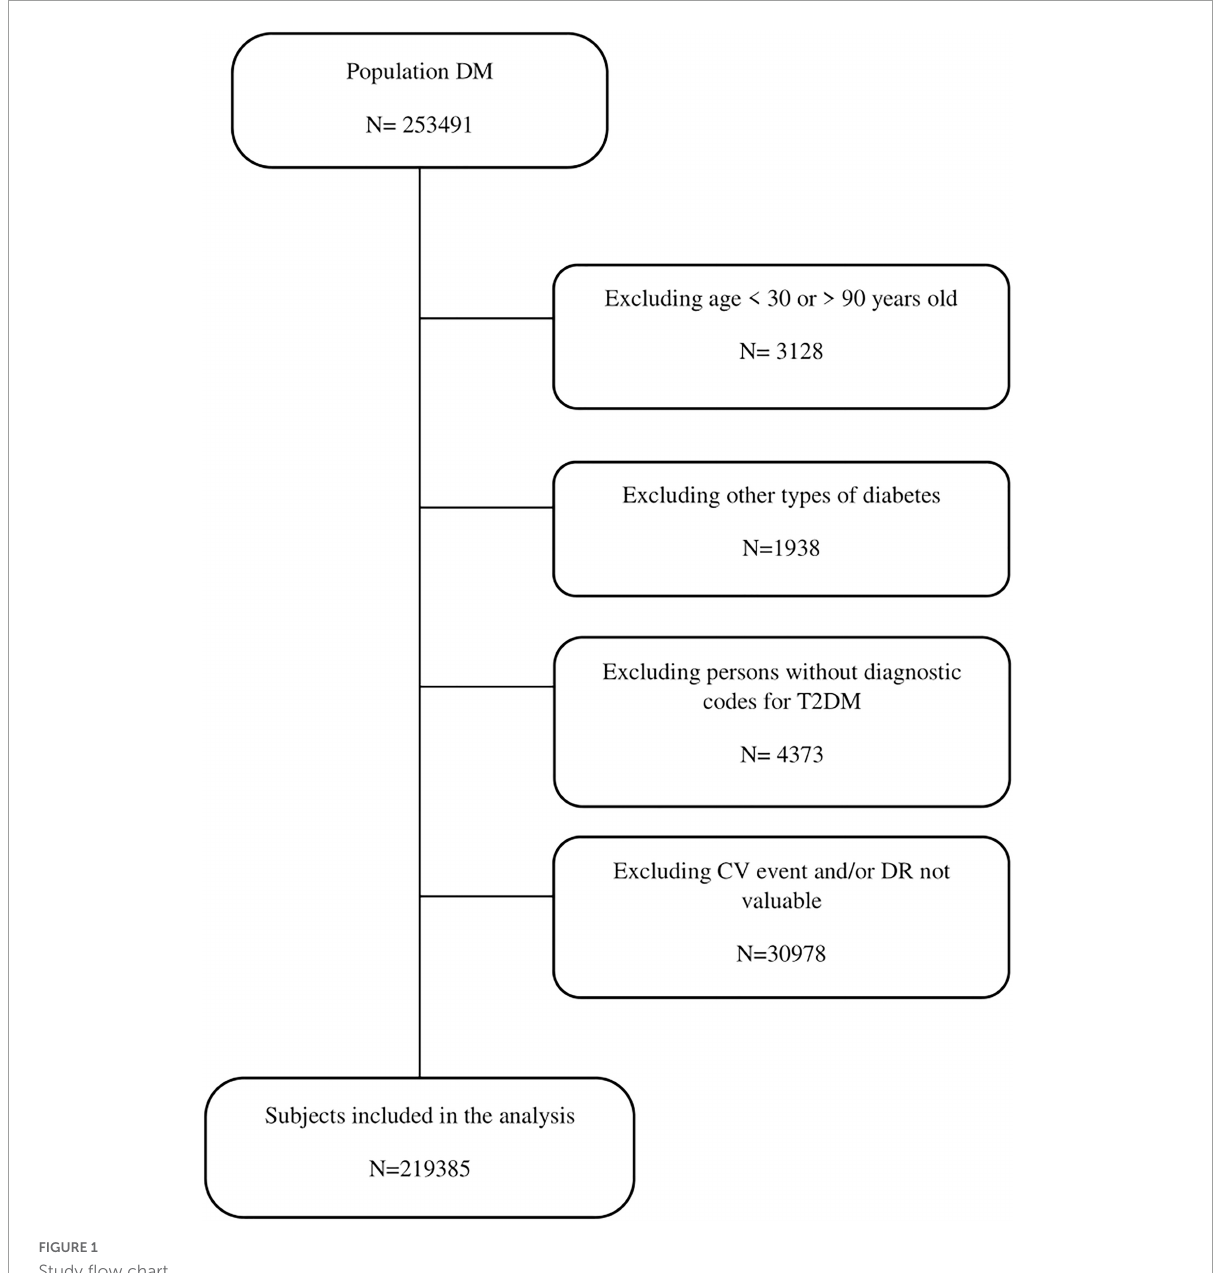
FIGURE1 Study flow